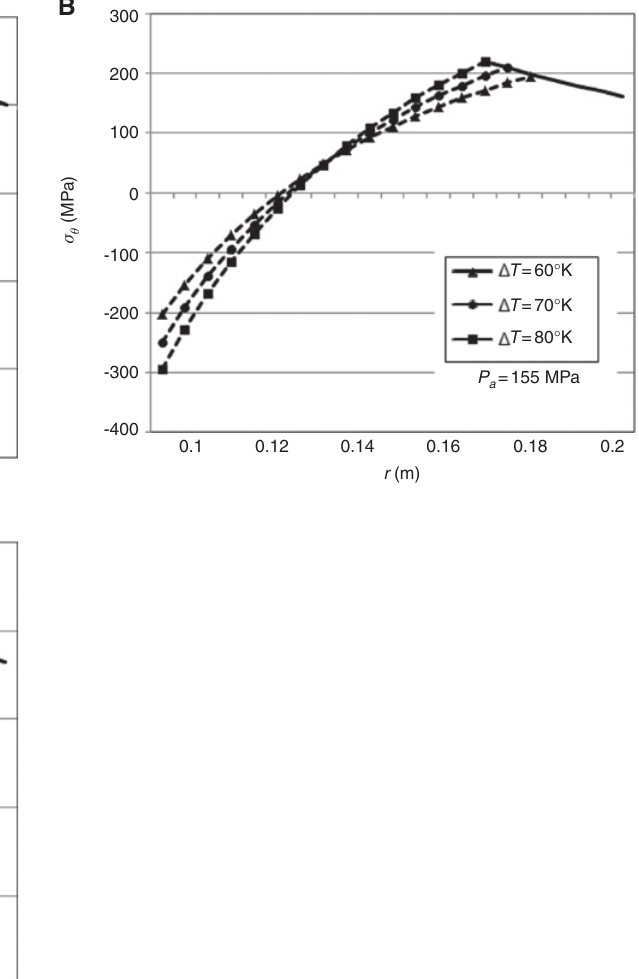
sional mesh format and contour plot, the boundary radius of elasto-plastic zones for an FG cylinder with 0.1 m inner and 0.2 m outer radii are shown in Figure